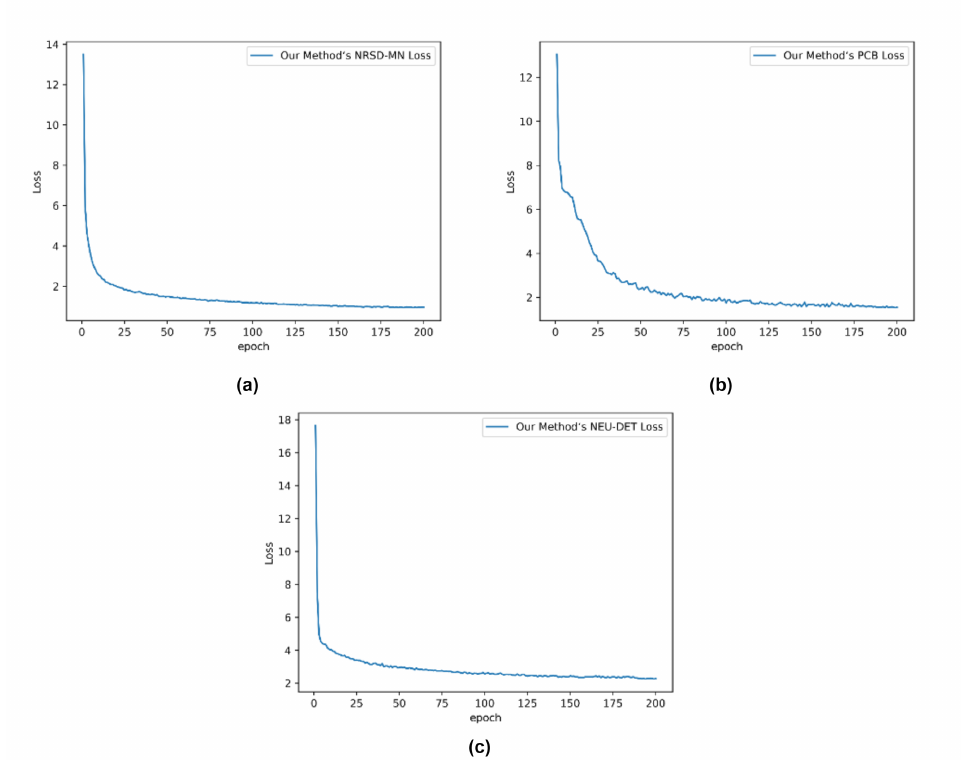
Figure 10. The loss curve after training. ( a ) Loss curve of NRSD-MN. ( b ) Loss curve of PCB. ( c ) Loss curve of